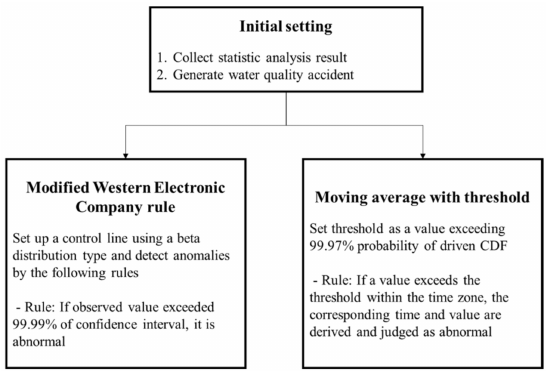
Figure 2. Procedure of anomaly